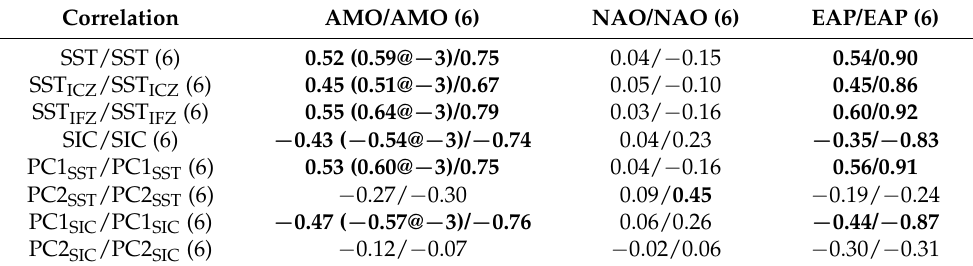
Table 1. Correlation coefficients (R) between annual/decadal (6-year running means) normalized SST, SIC, and their leading modes (PC1 and PC2), with the climatic mode indices (AMO, NAO, and EAP). Significant correlations ( p -values < 0.05) are highlighted in bold. The maximum correlation and time lag are shown in brackets to the right of R; negative lag refers to the lagged response of SST or SIC (@year) to the AMO index. SST ICZ and SST IFZ refer to SST over the ice-covered and ice-free zones,